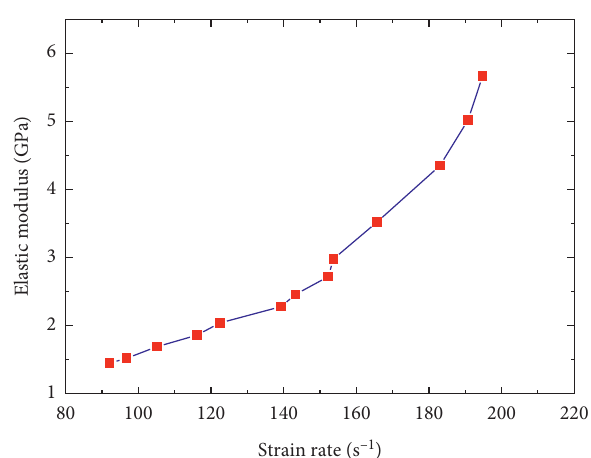
Figure 9: Elasticity modulus-strain rate.